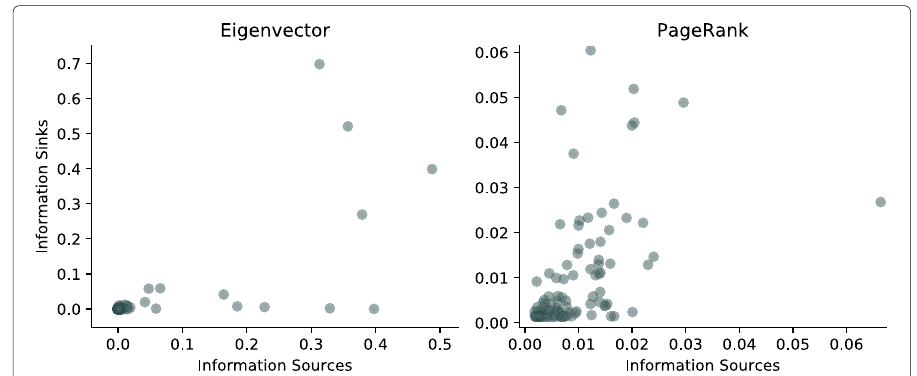
Fig. 3 Sensitivity of eigenvector and PageRank centrality measures to role interaction kernels. The horizontal axis gives centrality scores under the projection R T , while the vertical gives those under R . The PageRank teleportation parameter is α =